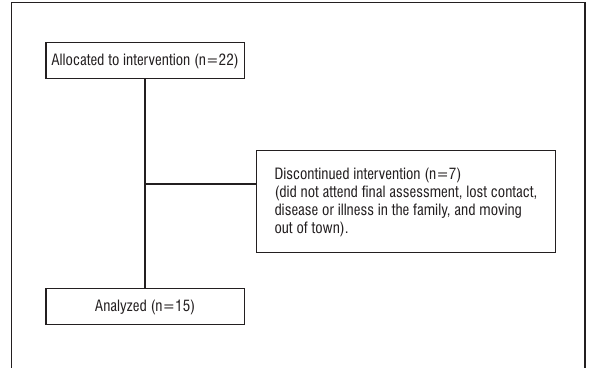
Figure 1 - Flow chart for volunteers’ recruitment Source: Research